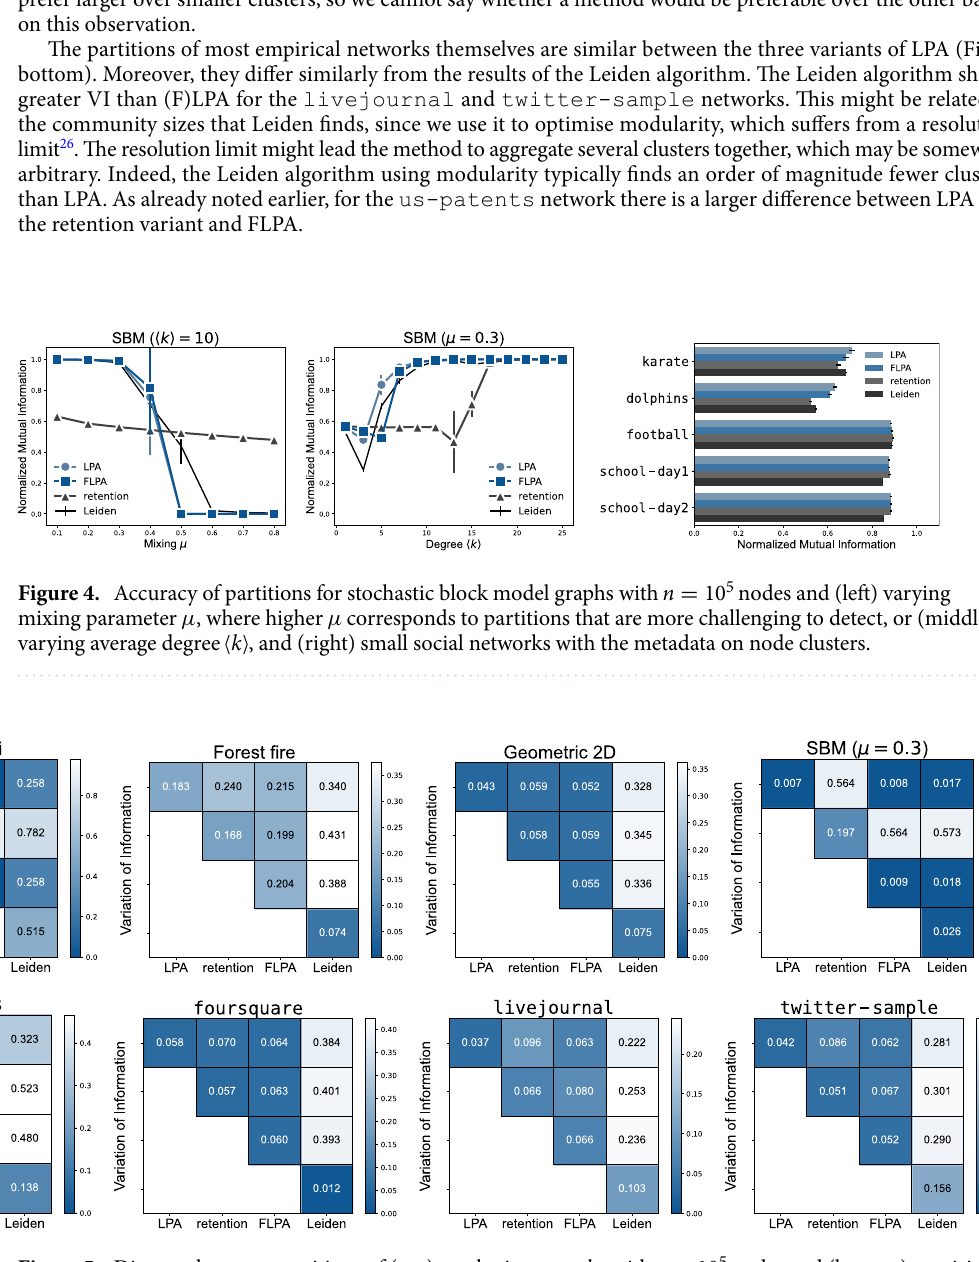
Figure 5. Distance between partitions of (top) synthetic networks with n = 10 5 nodes and (bottom) empirical